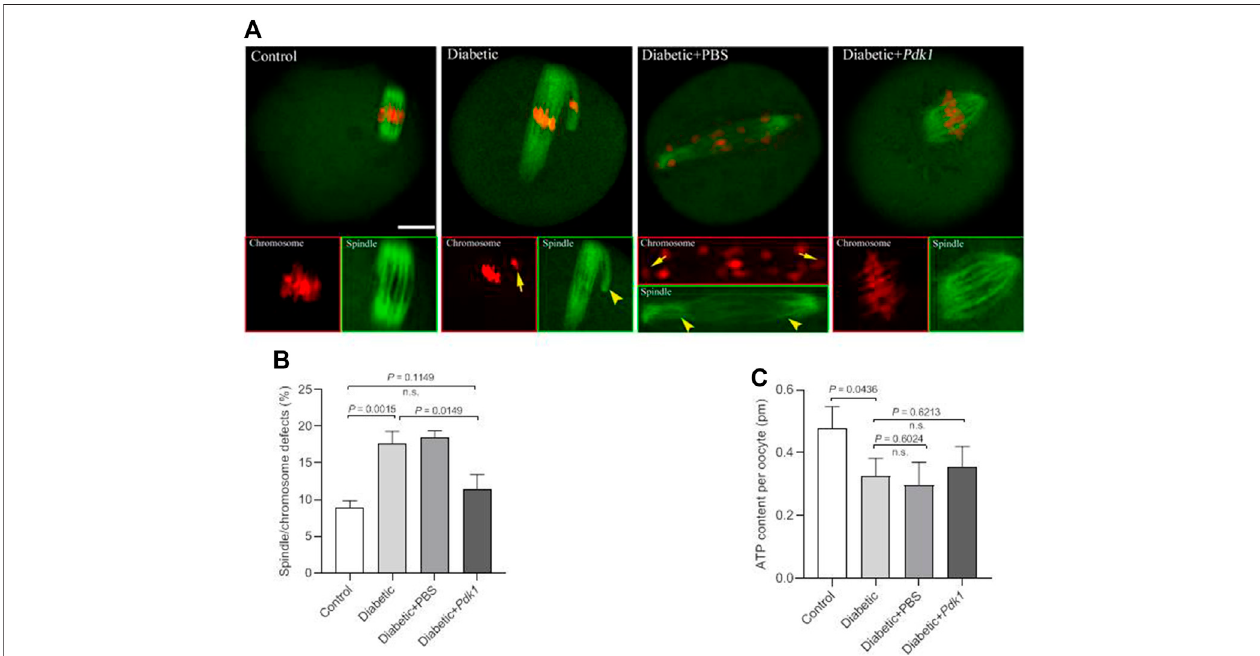
FIGURE 4 | PDK1 overexpression alleviates meiotic defects in diabetic oocytes. (A) Control, diabetic, diabetic + PBS, and diabetic + PDK1 oocytes were labeled with α -tubulinantibodytoshowthespindle(green)andstainedwithPItoshowchromosomes(red).Arrowsindicatechromosomemisalignmentandarrowheadsindicate spindle defect, respectively. Representative confocal images are shown. Scale bar: 20 µm. (B) Quanti fi cation of control, diabetic, diabetic + PBS, and diabetic + PDK1 oocyteswithspindle/chromosomedefects.Dataareexpressedasmeanpercentage ± SDfromthreeindependentexperimentsinwhichatleast120oocyteswere analyzed. n.s., not signi fi cant. (C) Measurement of total ATP content in control, diabetic, diabetic + PBS, and diabetic + PDK1 oocytes ( n (cid:1) 50 for each group). Data are expressed as mean percentage ± SD, student t test was used for statistical analysis. n.s., not signi fi cant.